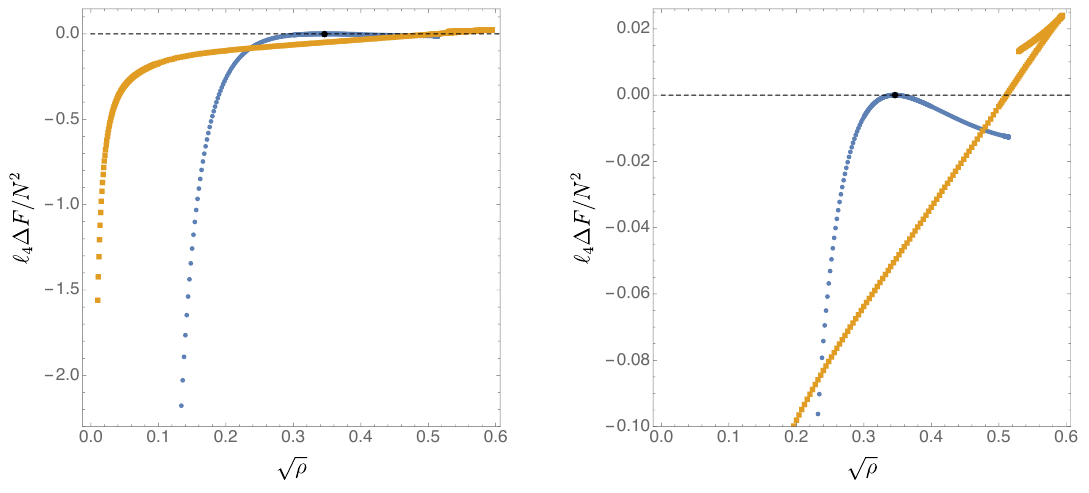
Figure 15 . Free energy of all the competing phases with (cid:12)xed boundary metric parametrised by (cid:26) : the orange squares represent the droplets and the blue disks the funnels. The right panel shows a close-up of the region close to where non-uniform and uniform funnels merge. The (cid:12)ner scale used in the close up makes the merger less apparent, but given the results of (cid:12)gure 13 we expect that further numerics pushing closer to the presumed merger would (cid:12)ll in the gap between the droplet and funnel free energies. The black disk represents the transition between stable and unstable non- uniform funnels. The close-up also includes the region where droplets are expected to merge with funnels, and in particular the turning point (cid:26) turn for the thin funnels. This turning point was easily visible in (cid:12)gures 10 and 12, showing (cid:12)nite di(cid:11)erences S thin (cid:0) S thinner < 0 and E thin (cid:0) E thinner < 0 when comparing two branches of thin funnels at the same (cid:26) . But the contributions nearly cancel when comparing free energies, so that the two parts of the thin funnel curve here are separated by much less than the width of the blue disks and the presence of two solutions near (cid:26) turn cannot be seen; i.e., as the funnels become even thinner they are now moving toward smaller (cid:26) and nearly retracing the curve de(cid:12)ned by their somewhat-less-thin relatives. However, there is a tiny di(cid:11)erence between the free energies of the two thin funnels at any given value of (cid:26) . In particular, numerical computations (cid:12)nd F thin (cid:0) F thinner < 0 as